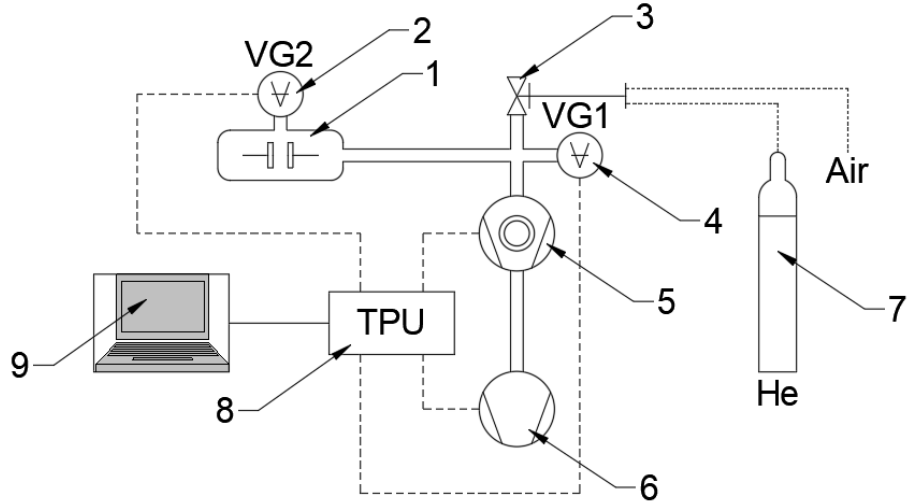
Figure 3. Schematic of the stand designed to determine the actual pressure value in the tested vacuum interrupters (1—prototype vacuum interrupter, 2—vacuum gauge VG2, 3—manual dosing valve, 4—vacuum gauge VG1, 5—turbomolecular pump, 6—rotary pre-pump, 7—gases dosed